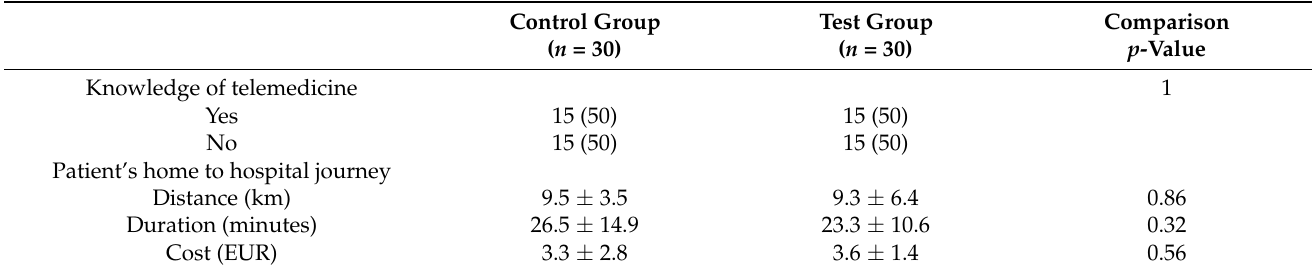
Table 2. Comparison of patients’ knowledge of telemedicine and access to hospital according to group ( n = 60). The values given are average ± standard deviation or number